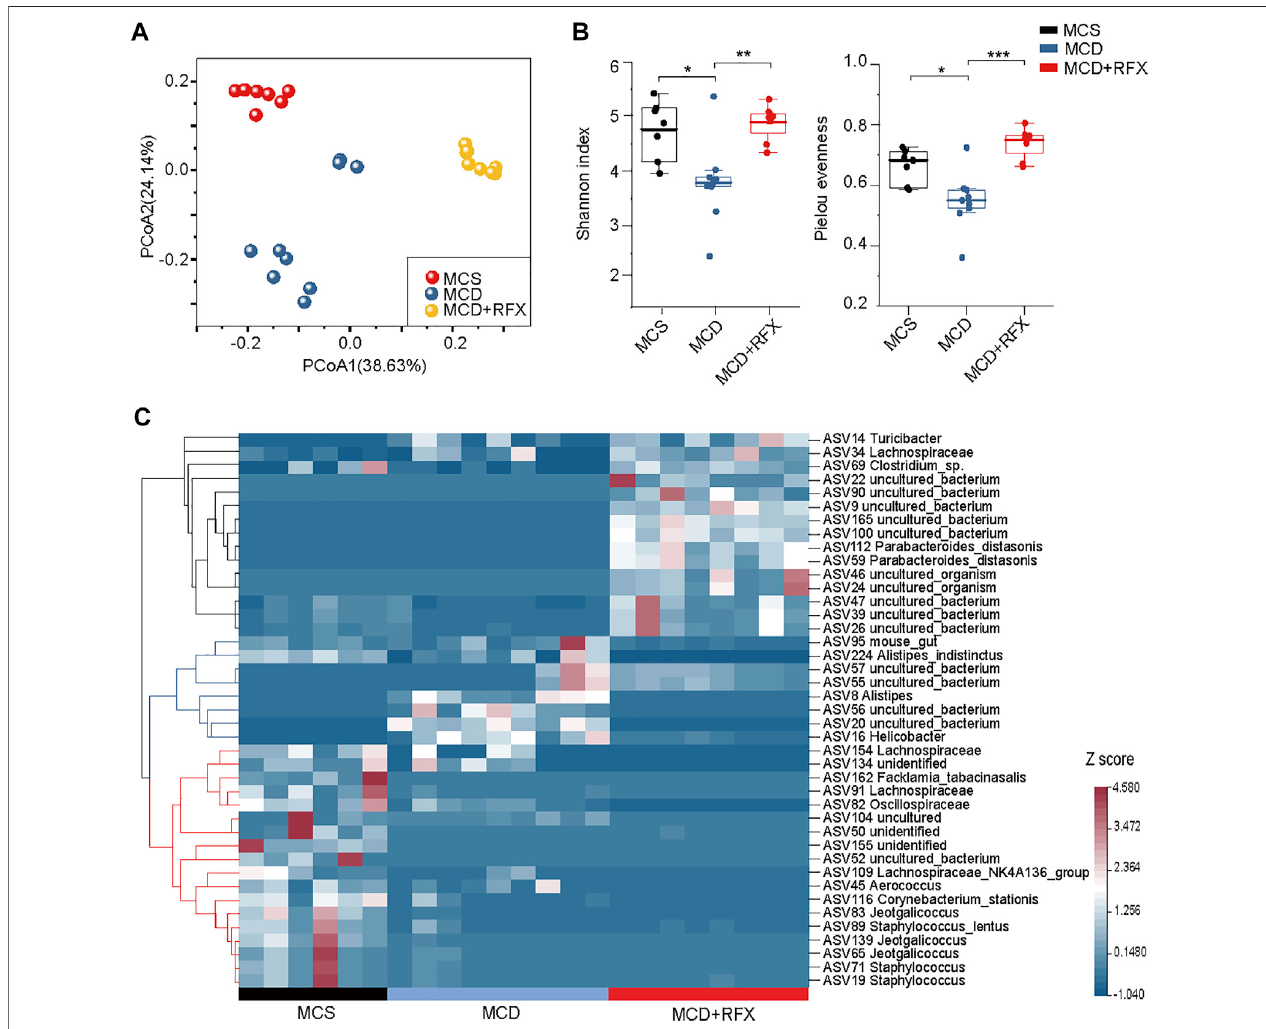
FIGURE 3 | Effects of rifaximin on the gut microbiome in the MCD diet induced NASH mice. (A) Clear separation of samples by diets and rifaximin treatment was observed via Principal coordinate analysis(PCoA) ofthe Unweighted UniFracdistancebased on ASVs. (B) Alpha diversityof three cohorts based on ASVs, measured in terms of the Shannon index and Pielou ’ s evenness. (C) The relative abundance of 41 differentially abundant ASVs identi fi ed by linear discriminant analysis effect size (LEfSe) (log(LDA) > 2 and p < 0.05) among the MCS diet, MCD diet, and rifaximin treatment groups through pairwise comparison between multiple groups. Clustering was performed using the Pearson measurement. * p < 0.05, ** p < 0.01, *** p < 0.001.